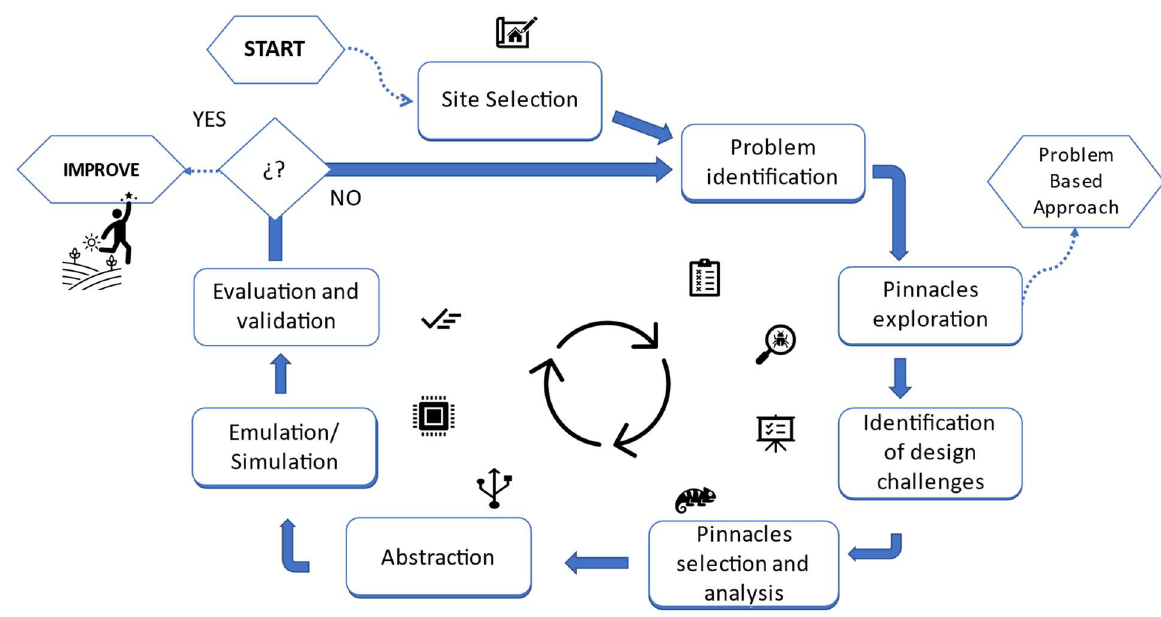
Figure 1. Proposed methodology for the development of the research.